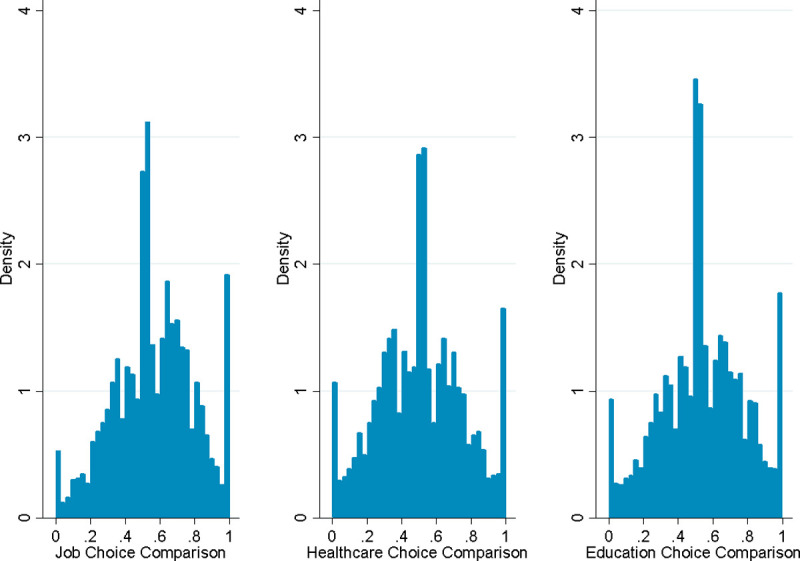
Distributions of comparison of choices of others to own.